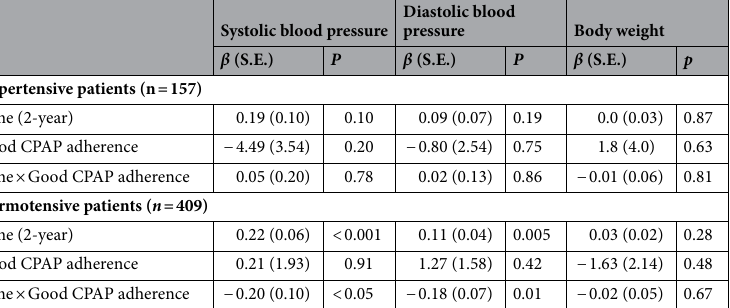
Systolic blood pressure